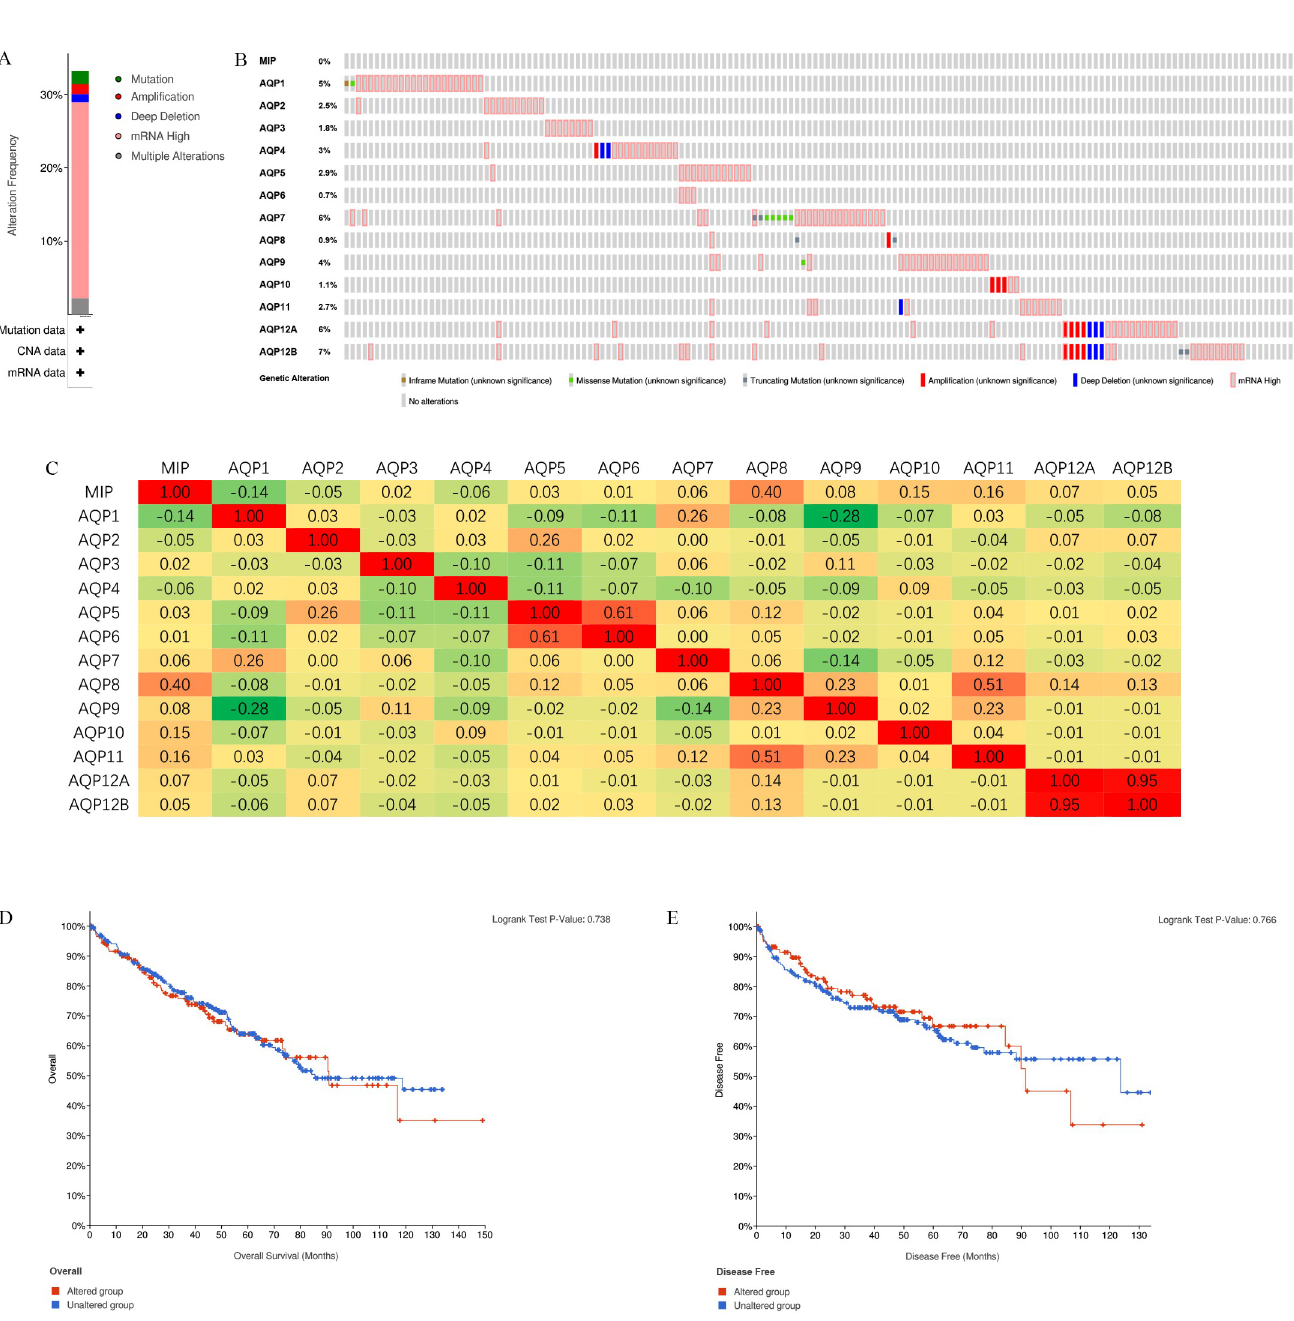
PLOS ONE | https://doi.org/10.1371/journal.pone.0264553 March 4,